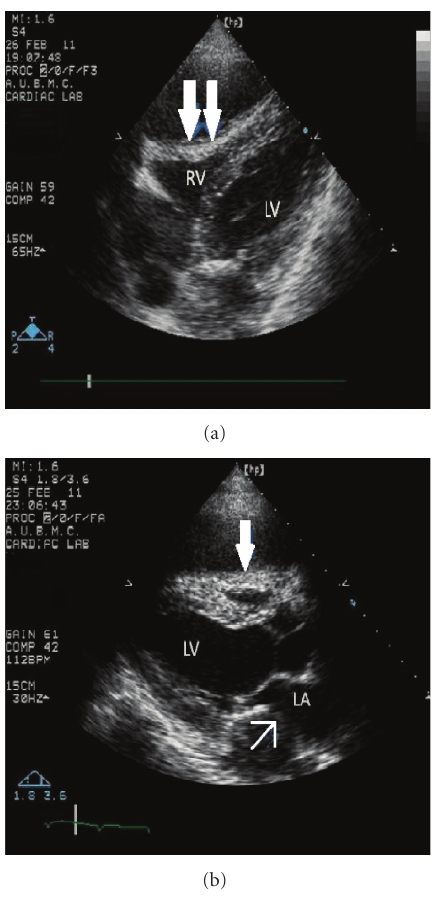
Figure 2: Echocardiography shows the cystic mass surrounding the heart (full arrows) with impingement on the right ventricle and left